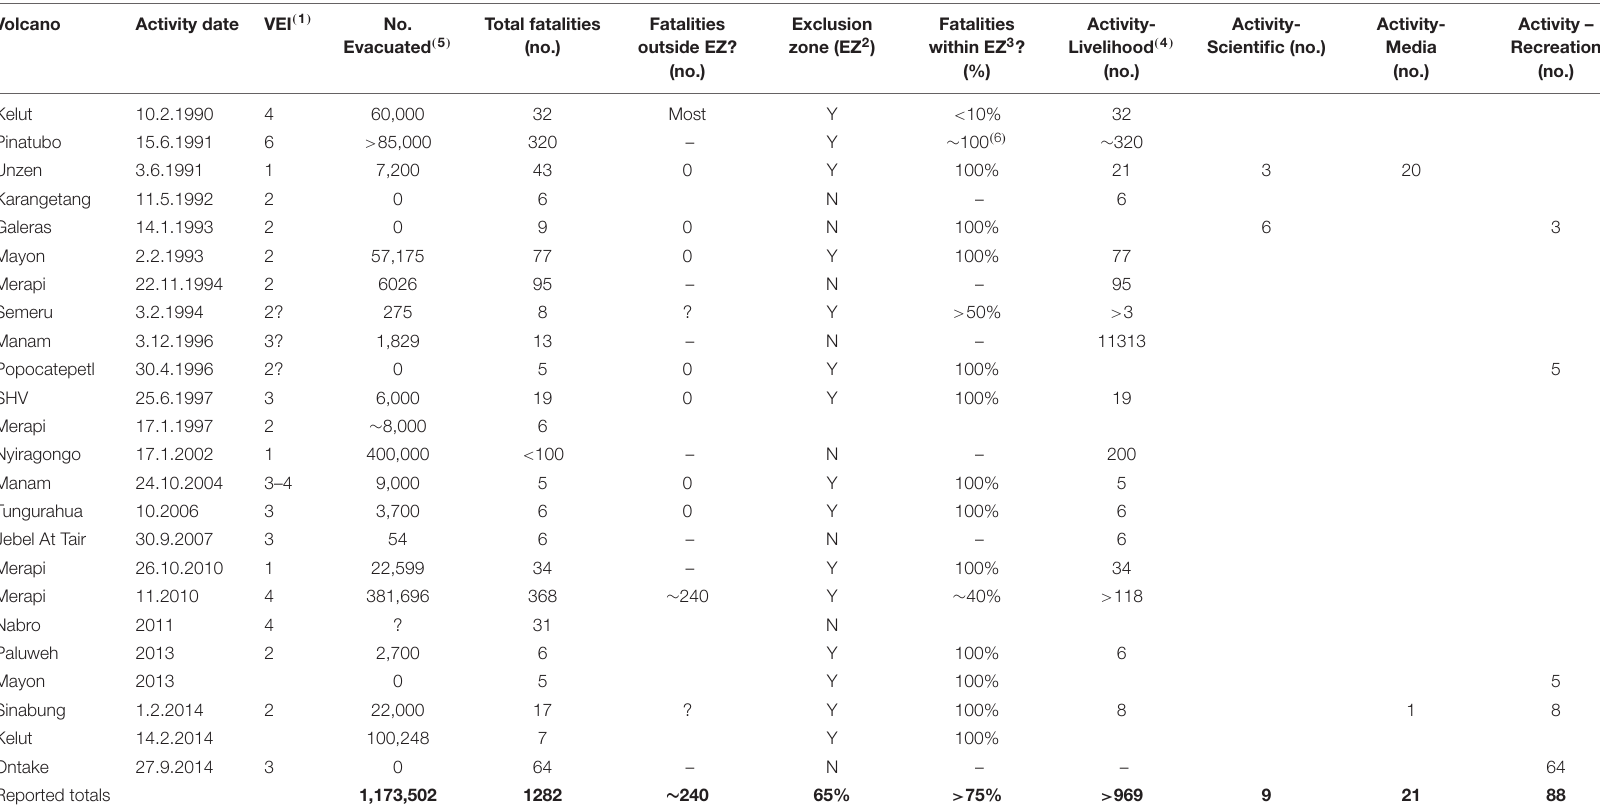
TABLE 1 | Analysis of affected populations for primary volcanic activity with > 5 associated fatalities since the mass casualty event of Nevado del Ruiz in 1985.